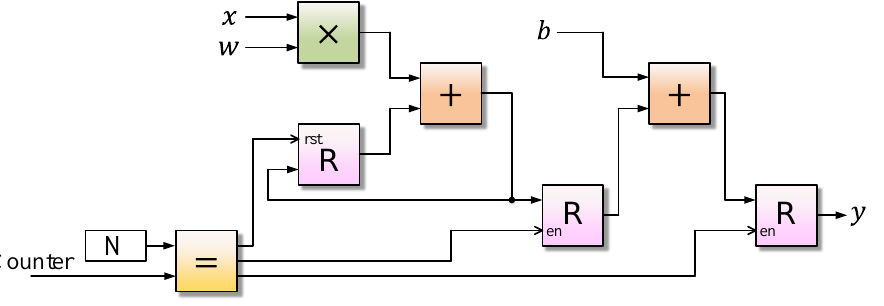
Figure 5. The design architecture of PE core.